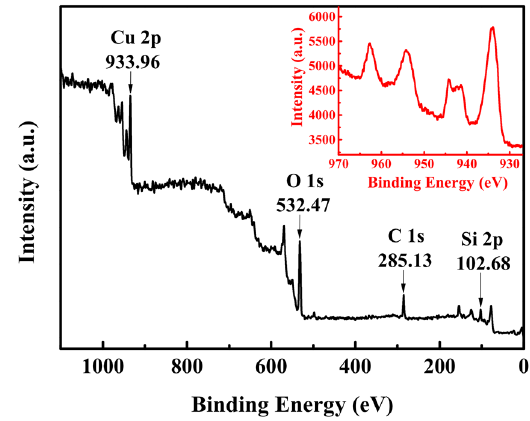
Figure 3. XPS spectra of PDMS-OCF and High-resolution XPS spectrum of Cu 2p in the PDMS-OCF